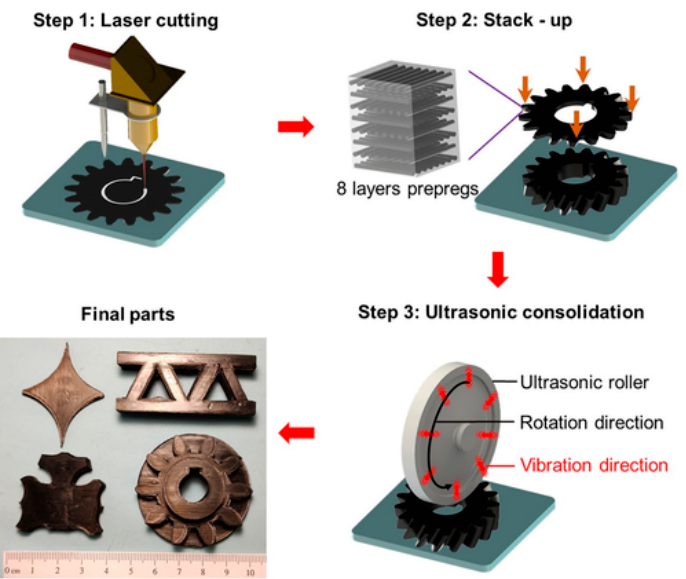
Figure 10. Schematic illustration of the ultrasonic-assisted laminated object manufacturing via AM method (adapted with permission from reference [34]). method (adapted with permission from reference [34]).